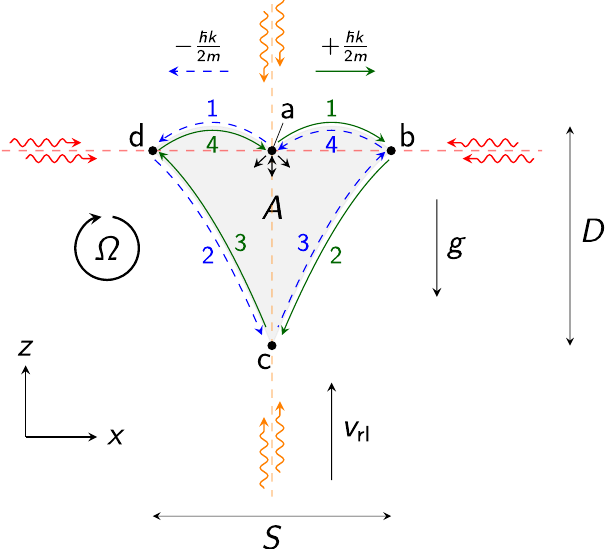
Figure 1. Trajectories of the free falling atoms in the interferometer. Red arrows denote the light fields for splitting, redirecting, and recombination. Orange arrows indicate the light fields for relaunching the atoms against gravity g with a velocity v rl enabling operation with a single beam splitting axis (red) and closing the interferometer at its starting point. The atoms start at (a) where a beam splitting pulse leads to a coherent superposition of two momentum states (blue, green) that separate symmetrically with a recoil velocity of (cid:31) k /( 2 m ) . Here, k denotes the effective wave number of the beam splitter (red) and m the atomic mass. ± One momentum state follows the green arrows and the second one the dashed blue arrows according to the numbering. The state deflected in positive x-direction (green) propagates from (a) to (b), (c), (d), and back to (a). Similarly, but with inverted momentum, the other state (blue) proceeds from (a) to (d), (c), (b), and back to (a), closing the loop. As a consequence, the interferometer encloses the area A (grey shaded area), rendering it sensitive to rotations (cid:31) . Both trajectories meet at (c) where the two momentum states are relaunched at the same time. Input (up) and output ports (down) of the interferometer are indicated by black arrows below (a). The maximum wave packet separation is indicated by S and the drop distance by D